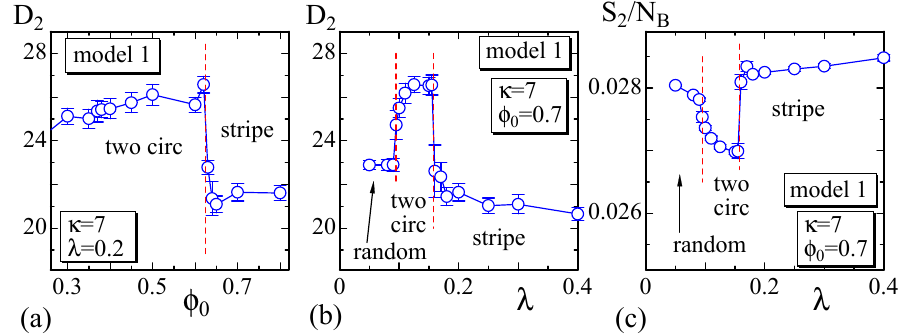
Figure 4. ( a ) The size D 2 vs. φ 0 at λ = 0.2; ( b ) D 2 vs. λ at φ 0 = 0.7; and ( c ) the bending energy S 2 / N B vs. λ at φ = 0.7. These are calculated on the dashed horizontal and vertical lines in Figure 3. The minor axis D 2 and the bending energy S 2 / N B change almost discontinuously and smoothly at the phase boundaries, which are denoted by the vertical dashed